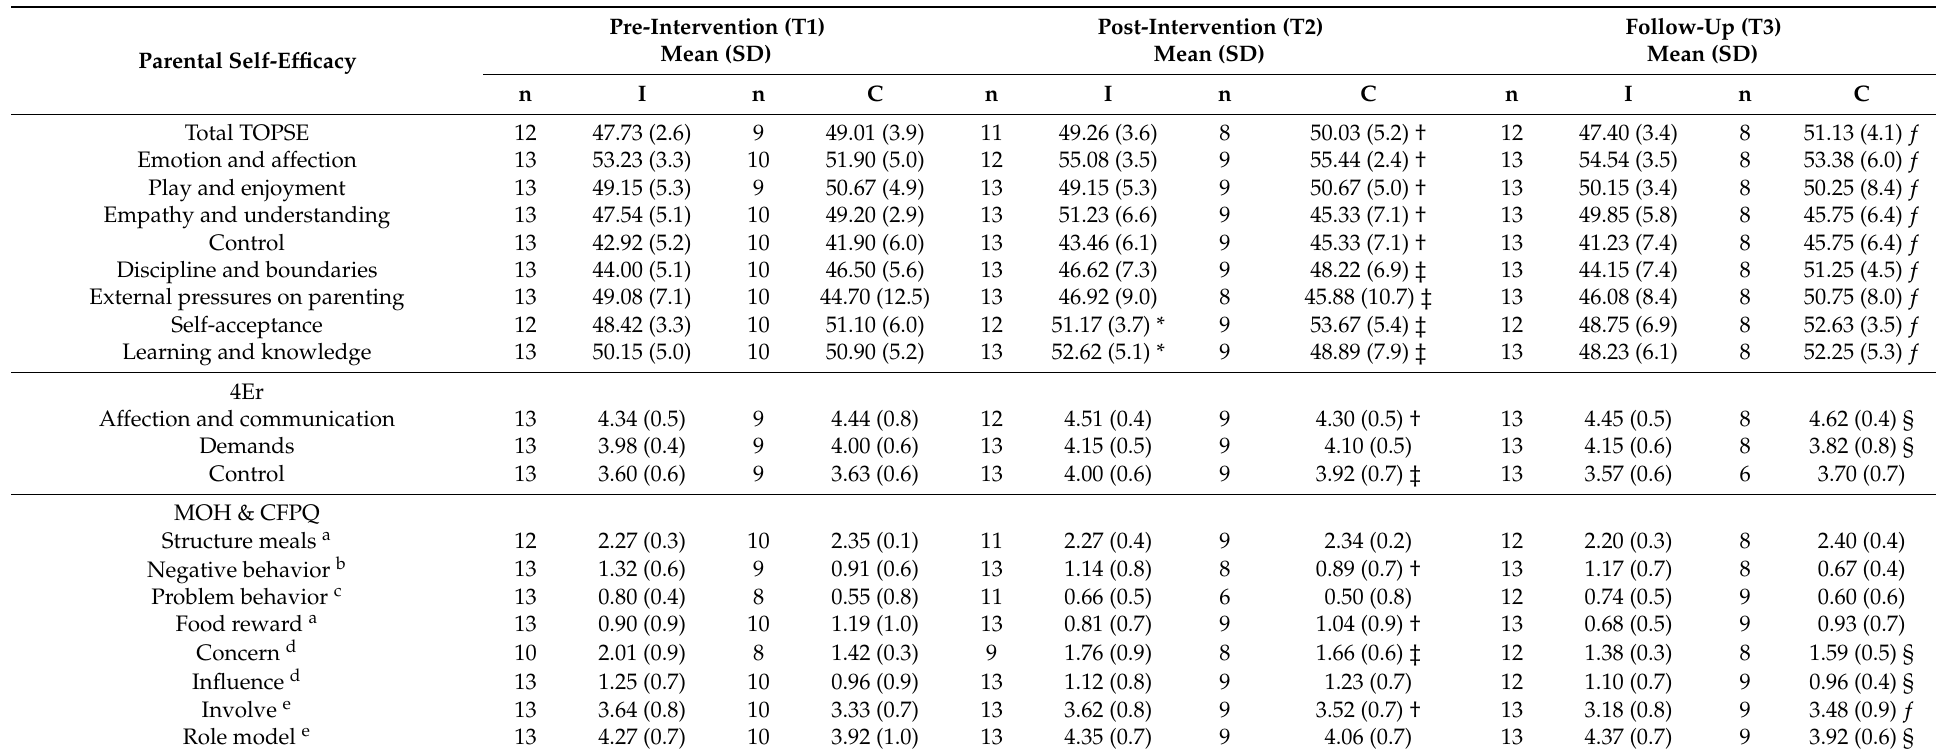
Table 2. Changes in TOPSE, 4Er, MOH and CFPQ scores from pre-intervention, post-intervention, and